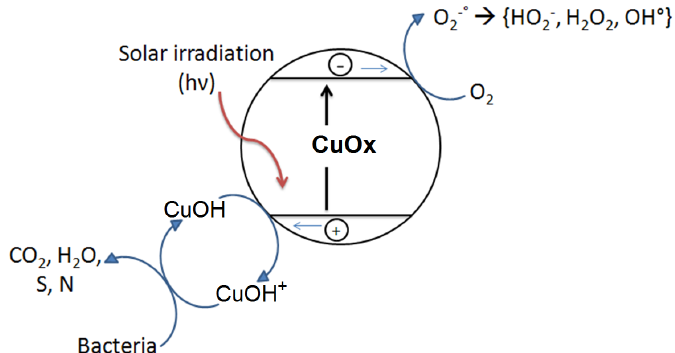
Figure 2. Conventional bacterial inactivation model on PE ‐ CuO x films under solar light irradiation. Copper is required by eukaryotic and prokaryotic cells at low concentrations as cofactors in